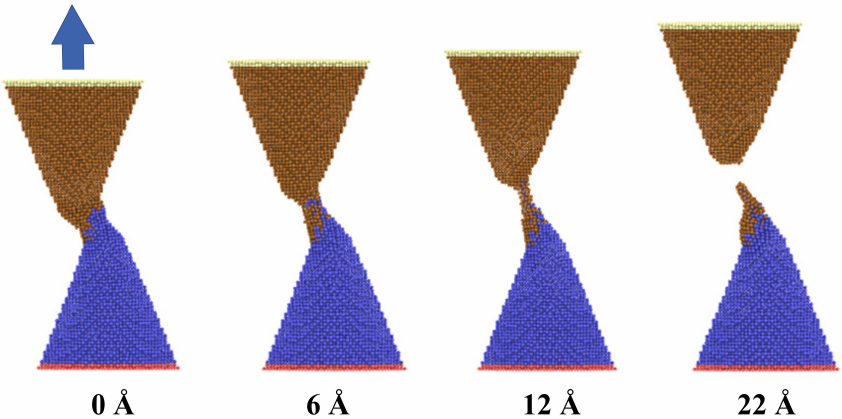
Figure 3. Snapshots of two copper nanocones with an initial axial separation of 20 Å and a contact length of 20 Å at different stages of the uniaxial tensile loading MD